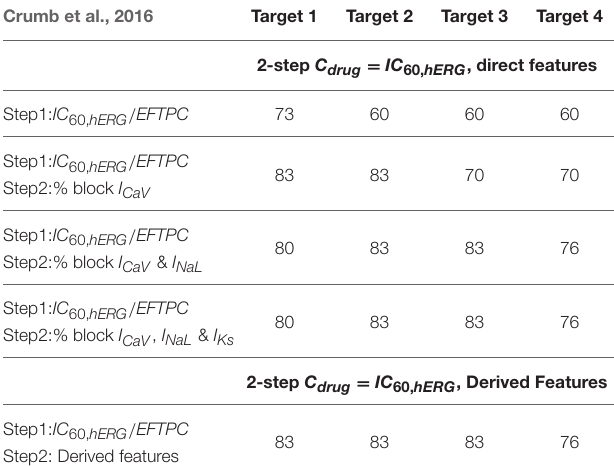
( Table 5 ). Using the block of I CaV currents provided the best accuracy scores under two of the four definitions (Target 1 and Target 2) for Dataset 5. Including the effects on additional